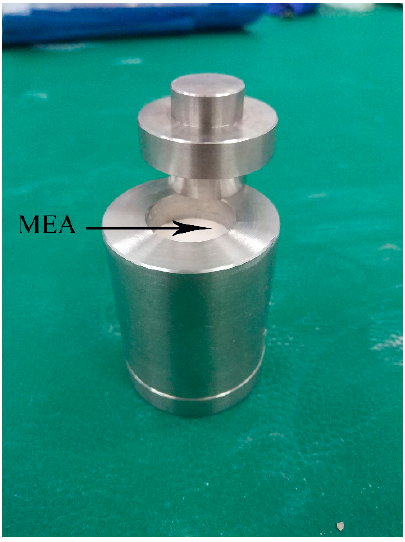
Figure 2. Physical sample mold.